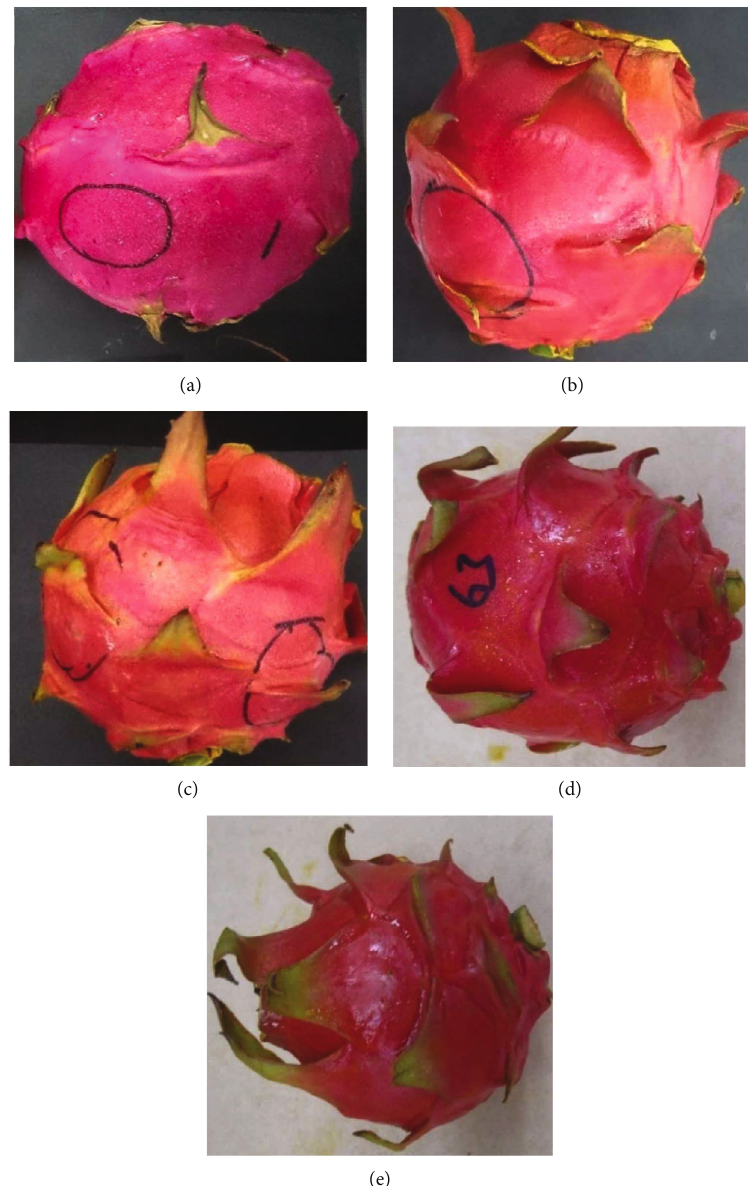
Figure 5: The external quality appearance of turmeric-coated fruit alone (upper row) and after incorporation with 10% GA (lower row) after 21 days of storage. Upper row (a – c): (a) control, (b) fruit coated with only 15 gL -1 of turmeric, (c) fruit coated with only 10gL -1 of turmeric. Lower row (d, e): (d) fruit coated with 10% GA+15g L -1 of turmeric, (e) 10% GA+ 10 gL -1 of